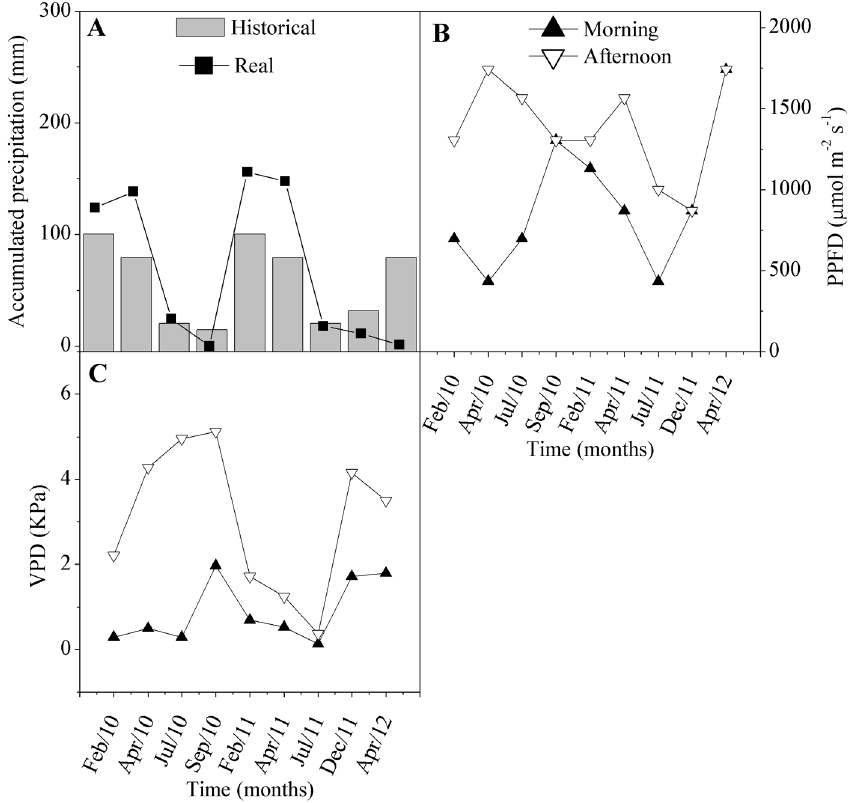
Figure 1. Environmental variables in Serra Talhada (Pernambuco, Brazil) over two years of measurements: (A) monthly total precipitation, (B) photosynthetic photon flux density (PPFD), (C) vapor pressure deficit (VPD). Historical precipitation data represent